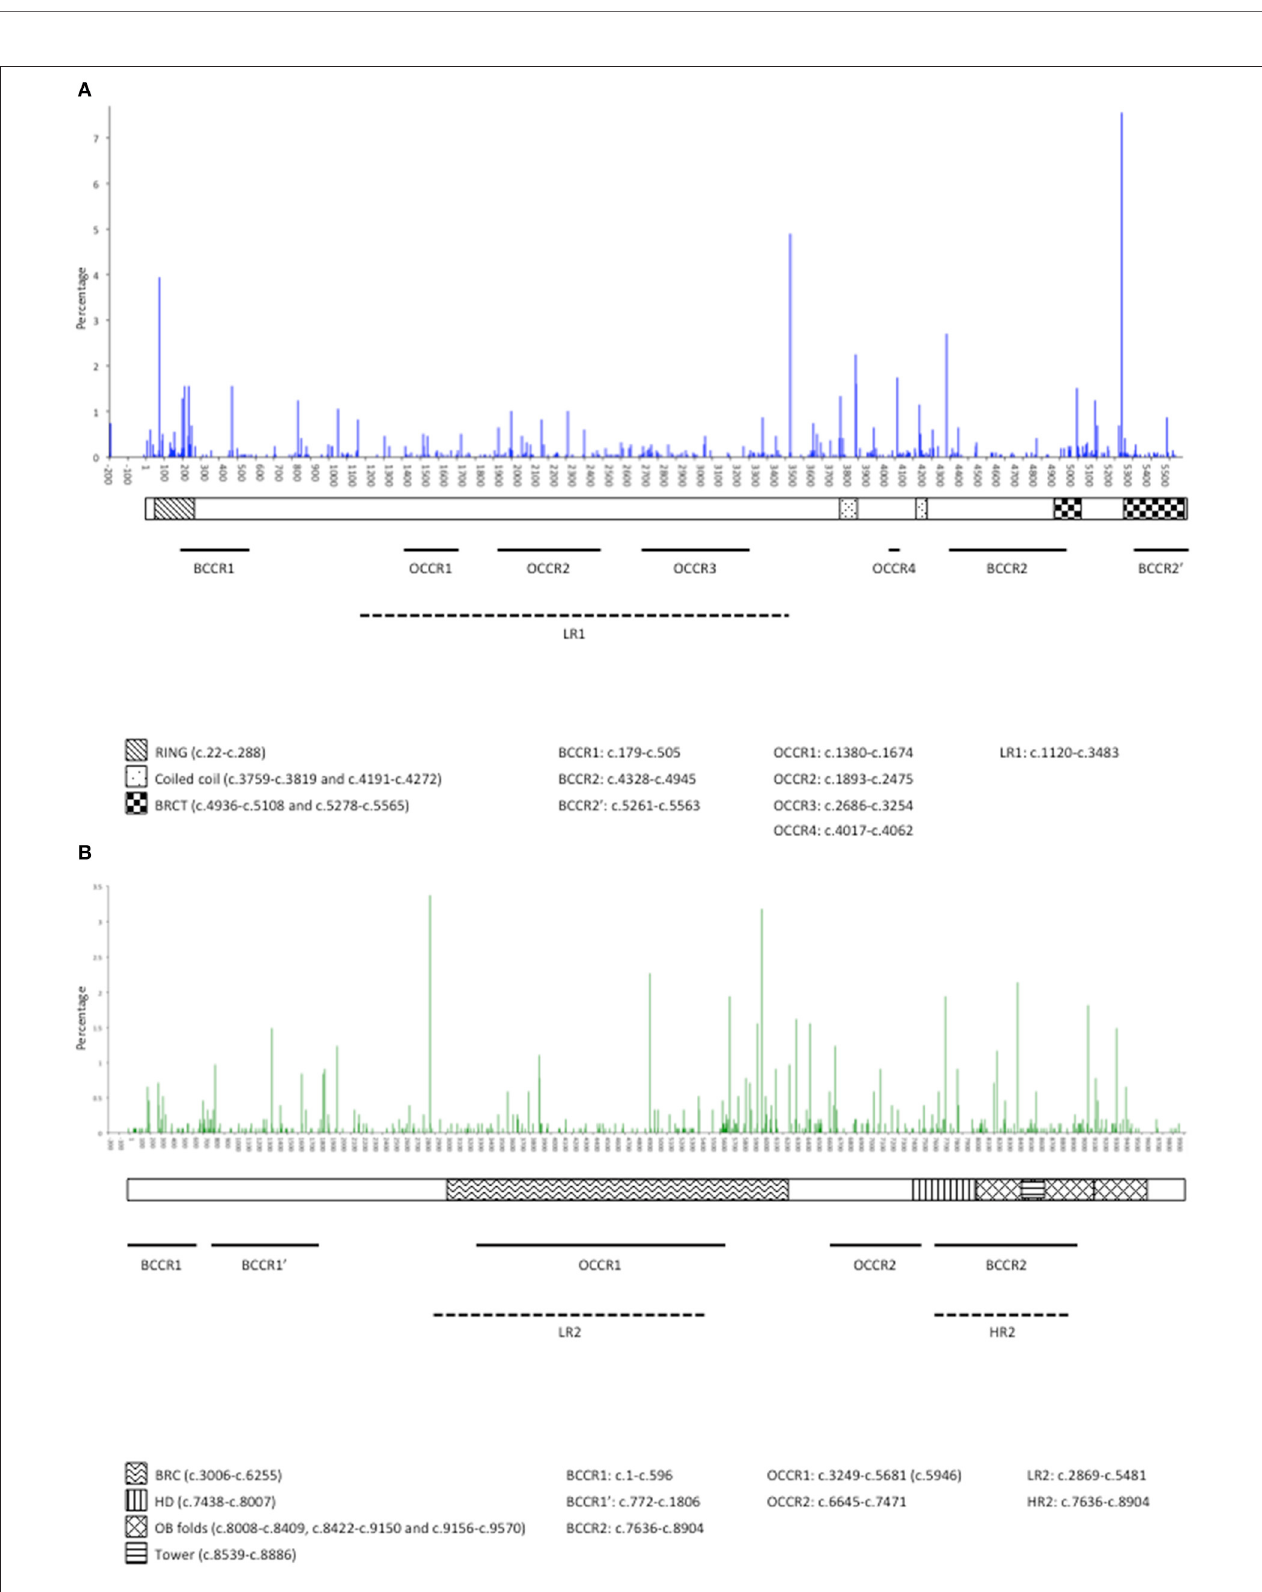
FIGURE 1 | Distribution and occurrence of pathogenic variants along BRCA1 (A) and BRCA2 (B) in probands in the GEMO study. BRCA1 domains are: RING domain, Coiled Coil domains, BRCT (BRCA1 C-terminal) domains (14, 27). BRCA2 domains are: BRC repeats, helical domain (HD), OB fold binding domains, tower alpha (14, 28). Breast cancer risk regions: LR1, lower risk region in BRCA1 , LR2 lower risk region in BRCA2 , HR2, higher risk region in BRCA2 (29); BCCR, breast cancer cluster region (14); Ovarian cancer risk regions: OCCR, ovarian cancer cluster region (14).